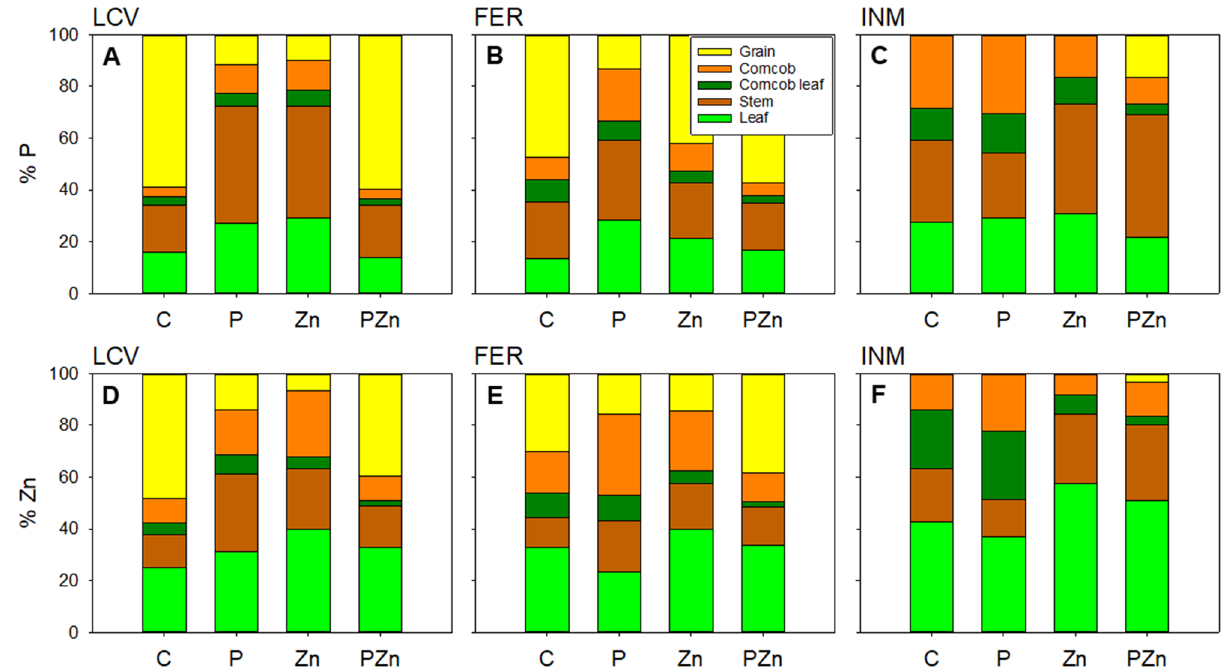
Figure 1. P and Zn distribution (%) in different plant parts (mean, n = 4) at harvest by treatment ( C : no P or Zn was added; P : fertilization with 40 mg P kg −1 but no Zn; Zn : fertilization with 3 mg Zn kg −1 but no P; PZn : fertilization with 40 mg P kg −1 and 3 mg Zn kg −1 ). ( A , D ), soil LCV. ( B , E ), soil FER. ( C , F ), soil